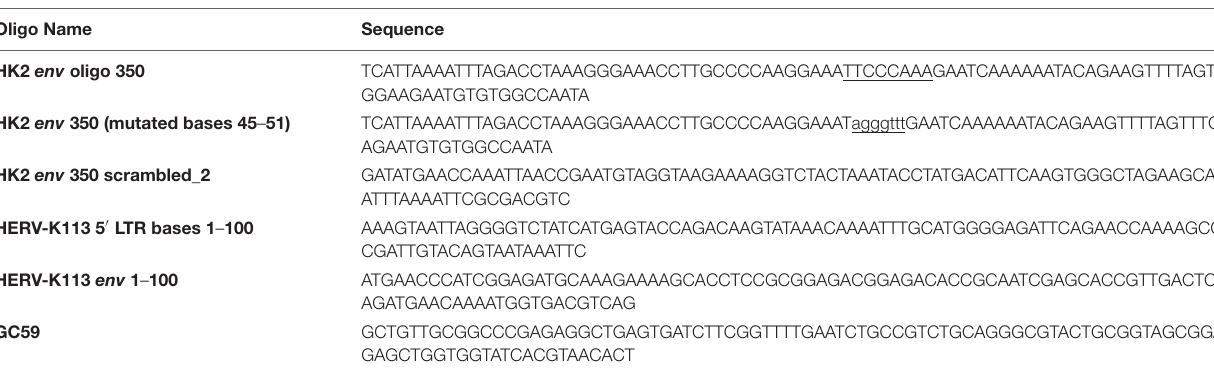
TABLE 1 | Sequences of HERV